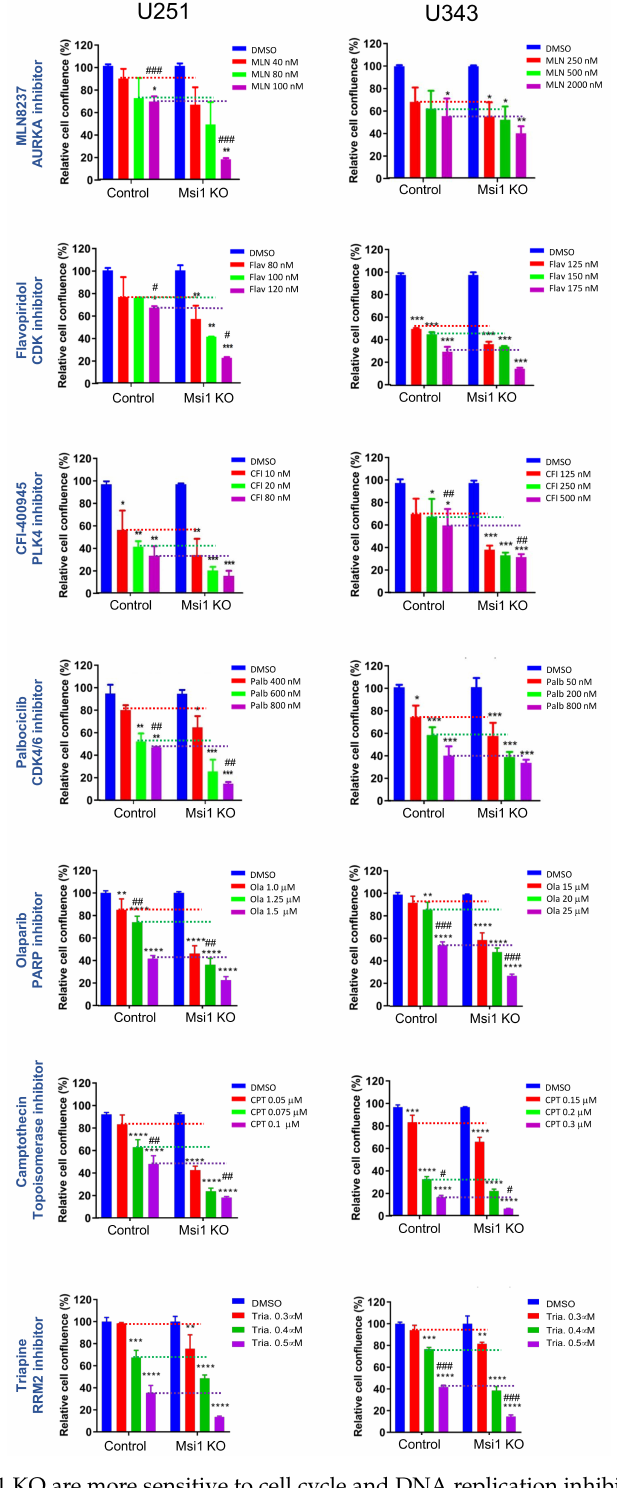
Figure 5. GBM cells with Msi1 KO are more sensitive to cell cycle and DNA replication inhibitors. Graphs show the impact of different cell cycle and DNA replication inhibitors on proliferation (72 h) of U251 and U343 Msi1 KO cells in reference to their respective controls (DMSO treated). Statistical significance was calculated by one-way ANOVA and t-test. Data shown as means ± s.d. (* p < 0.05, ** p < 0.01, *** p < 0.001, **** p < 0.0001). Synergy between “Msi1 KO” and cell cycle and DNA replication inhibitors was determined by the statistical response additivity approach [41], with # indicating the drug concentration in which we observed the statistically most significant synergy (# < 0.05, ## < 0.01, ### <